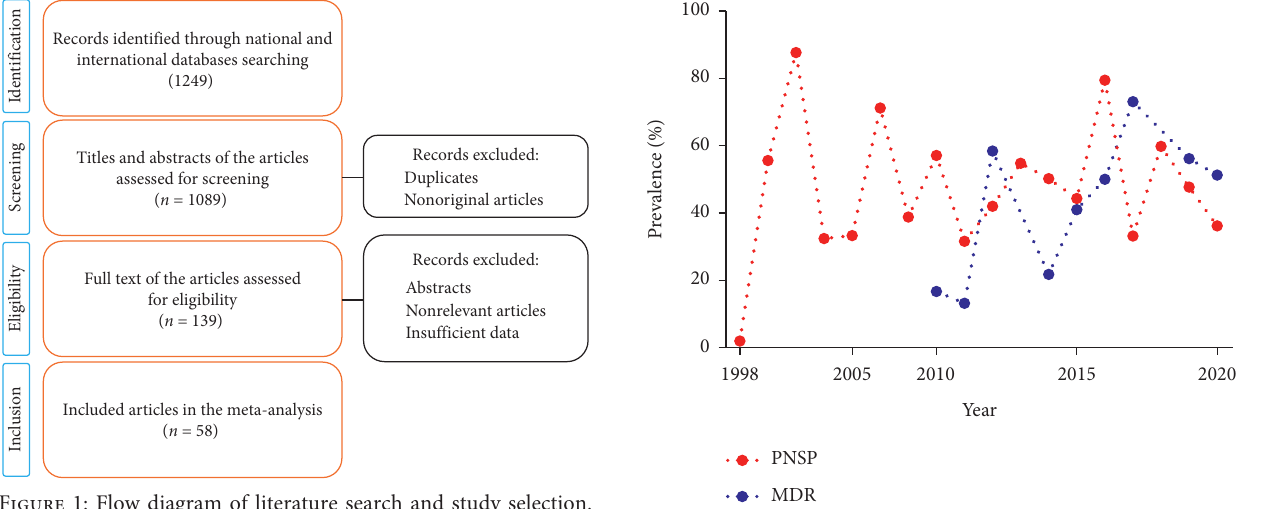
Figure 2: Total trend in the prevalence rate of PNSP and MDR strains in all age groups in Iran over time (based on the year of